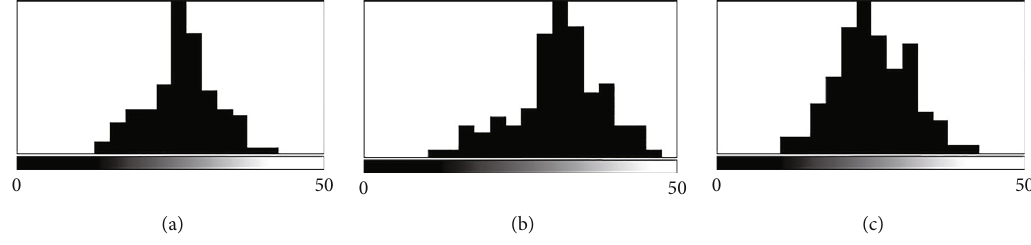
Figure 7: The size distribution of layers: (a) HT, (b) LT2, and (c)